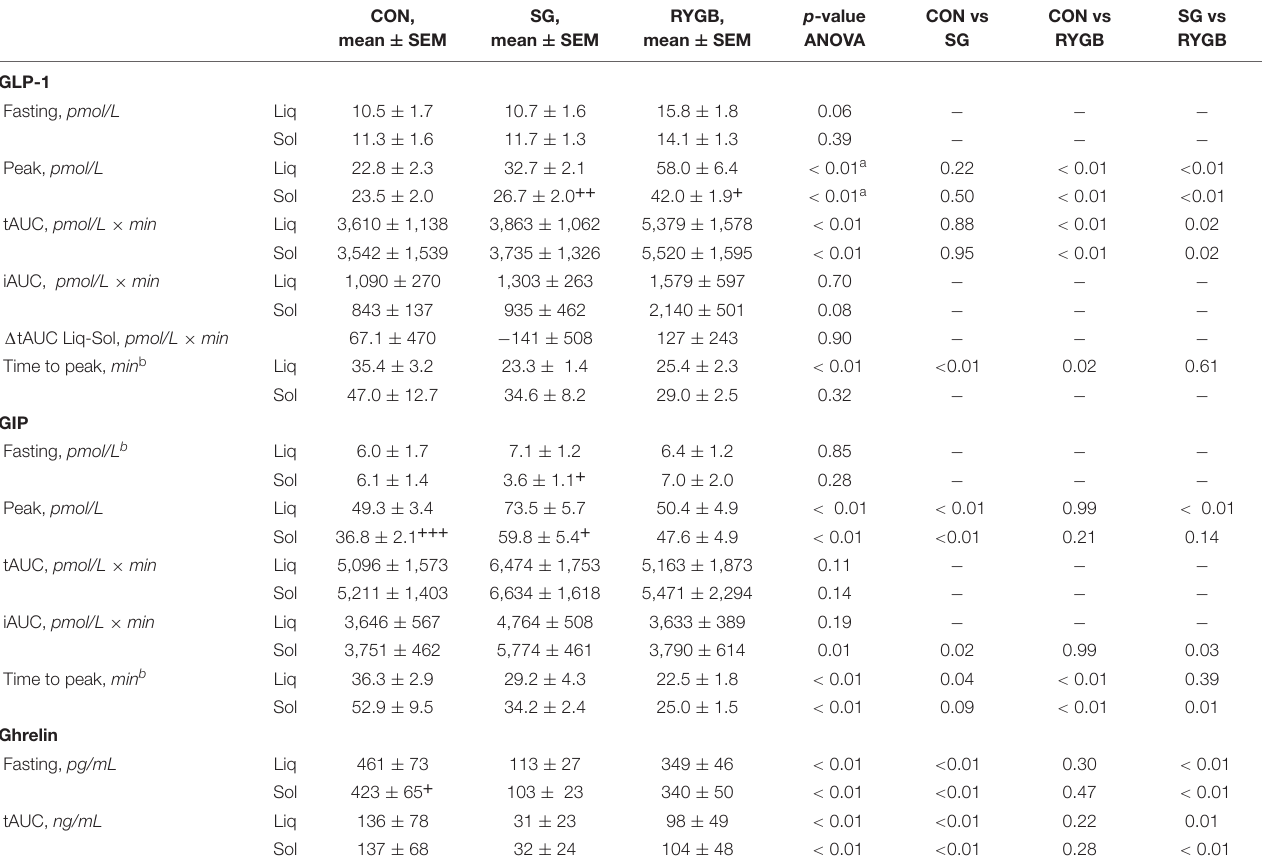
Data are mean ± SEM, t-AUC, total are under the curve, i-AUC, incremental area under the curve with the subtraction of baseline concentration. GLP-1, glucagon-like peptide-1; GIP, glucose-dependent insulin tropic polypeptide. Comparisons within groups were made using paired two-sample t-test. Between-group differences were evaluated with an ANOVA, followed by a post hoc Tukey’s